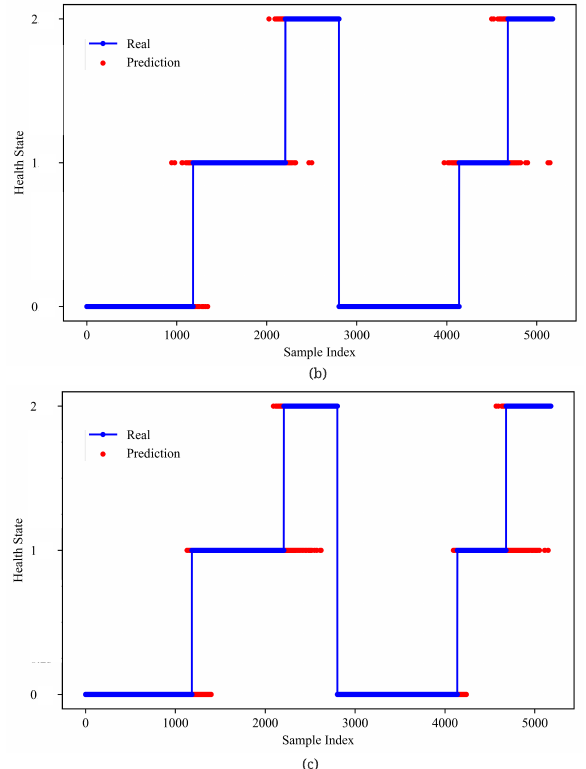
Figure 14. Health state prediction of five models ( a ) 0 Gate; ( b ) 1 Gate(GMM-Net); ( c ) 2 Gates. Samples from bearing 1_1 and bearing 1_3 are joint from left to right.